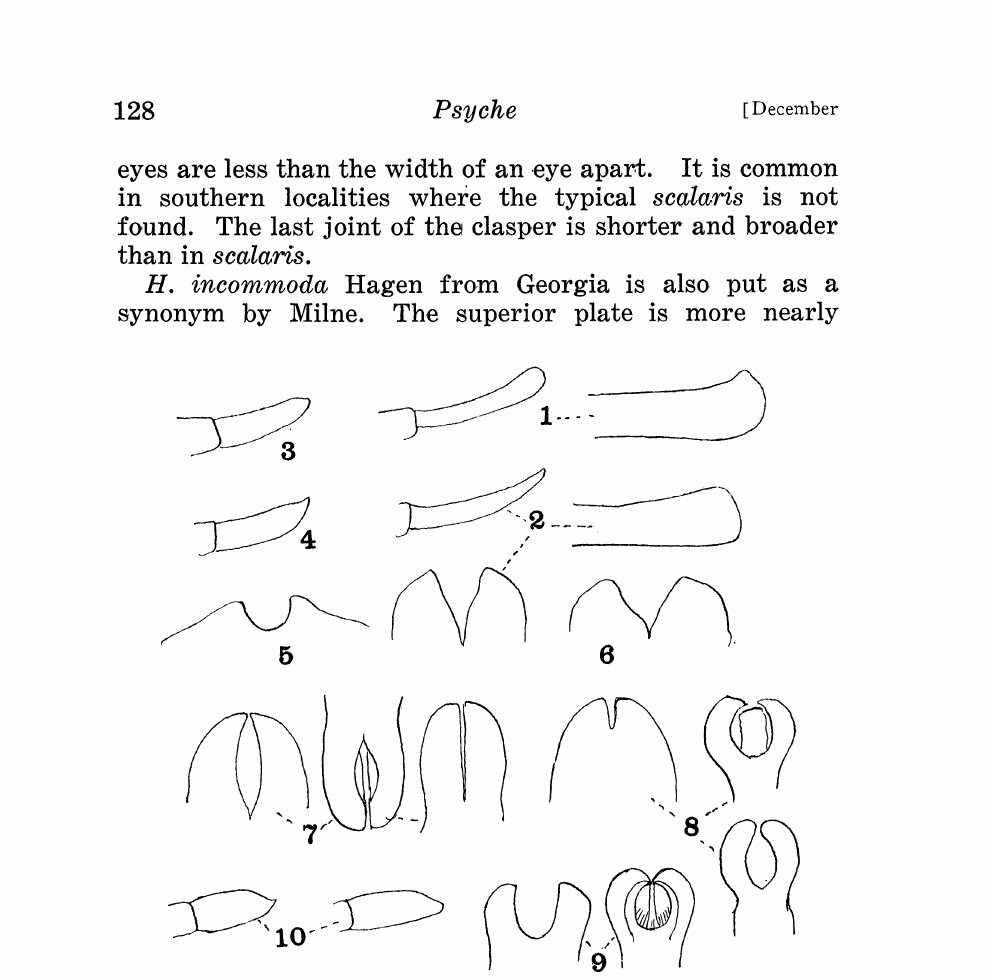
Fig. 1. Male .genitalia of Hydropsyche. 1, H. sepaata, .clasper and penis; 2, H. reciproca, clasper .and penis, and superior plate;